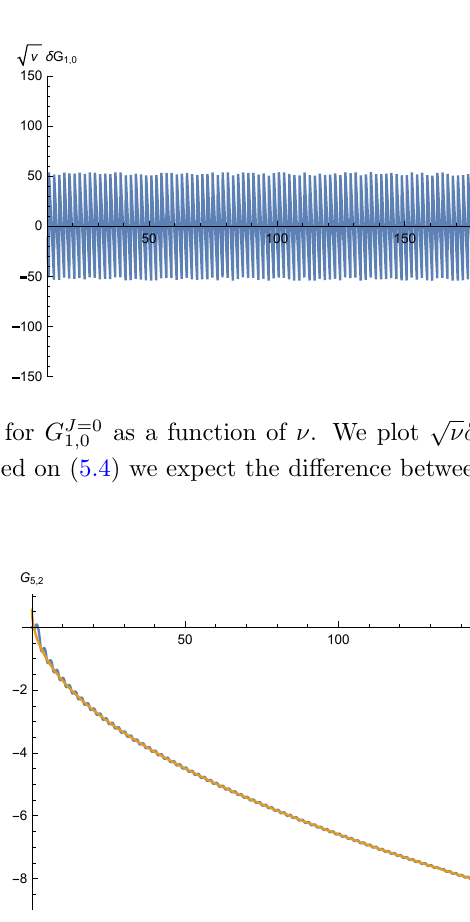
Figure 2 . G J =0 for GFF as a function of (cid:23) . Parameters are chosen to be d = 3, J = 0, (cid:14) (cid:30) = 5 1 ; 0 Based on (5.4) we expect the leading term to be 8(cid:0)( (cid:0) The asymptotic formula works very well down to (cid:23) = 0.